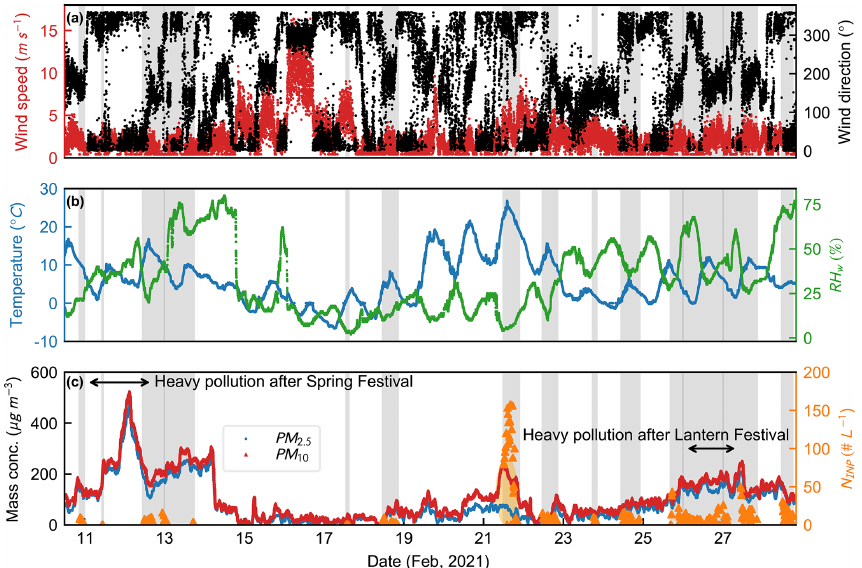
Figure 3. Times series of (a) wind speed and direction, (b) ambient temperature and relative humidity with respect to liquid water (RH w ), and (c) PM 2 . 5 and PM 10 mass concentrations and immersion INP number concentration ( N INP ). The grey shading in each panel indicates IN experiment time periods; the orange shading and arrows in (b) mark the dust event on 21 February 2021 and the heavy pollution after celebrations,